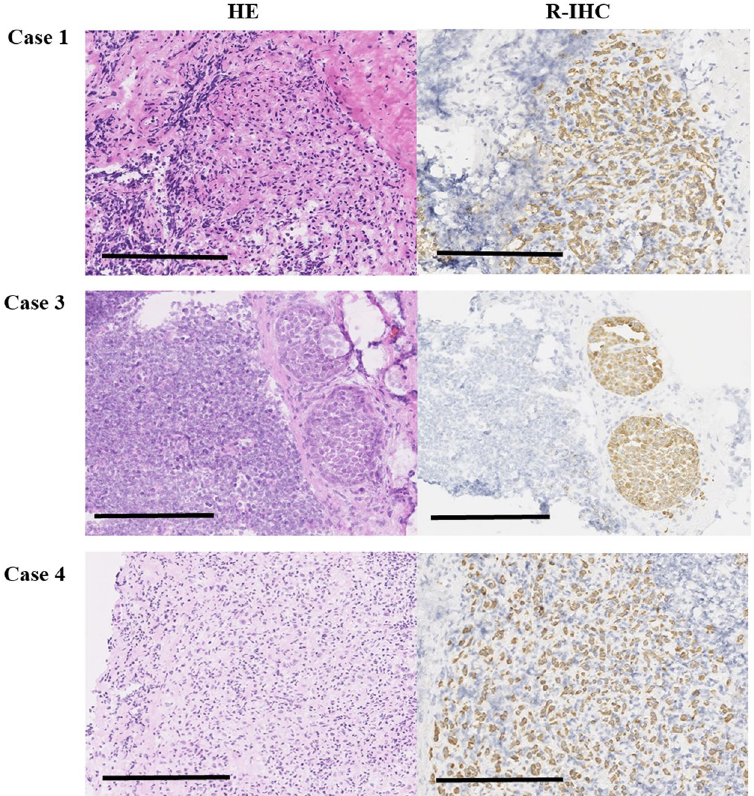
Figure 1. Images showing cytokeratin immunoreactivity within metastatic SLNs from the indicated cases. The tissue sections were stained with HE or with anti-cytokeratin antibody using R-IHC (bar = 200 µ